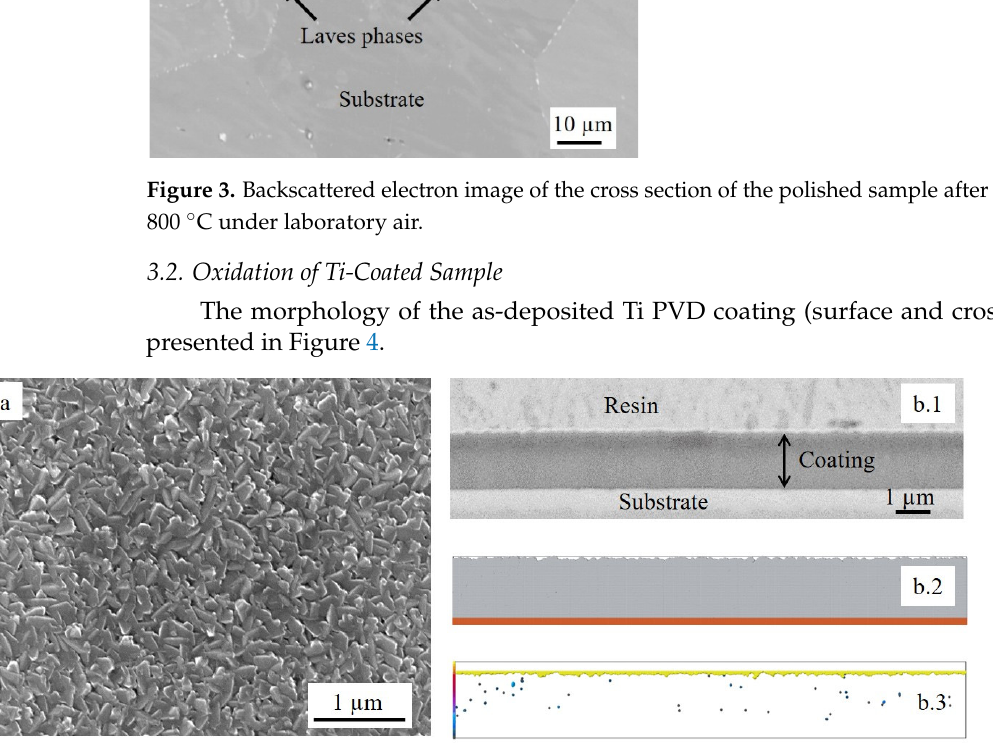
Figure 4. Morphologies of the as-deposited Ti PVD coating: ( a ) surface and ( b.1 ) cross section, ( b.2 ) simulated film growth using NASCAM, and ( b.3 ) porosity of the simulated film.